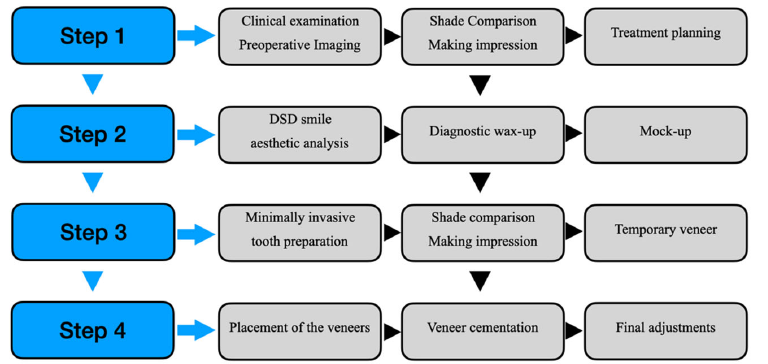
Figure 1. The clinical visit and operation flow chart for micro ‐ veneer. Step 1 mainly collects patient data and makes a preliminary plan. Step 2 is to create an aesthetic design based on the information. Step 3 is to make the necessary preparations for the affected tooth and collect the data about the affected tooth again. The final step is bonding the prosthesis and finishing.